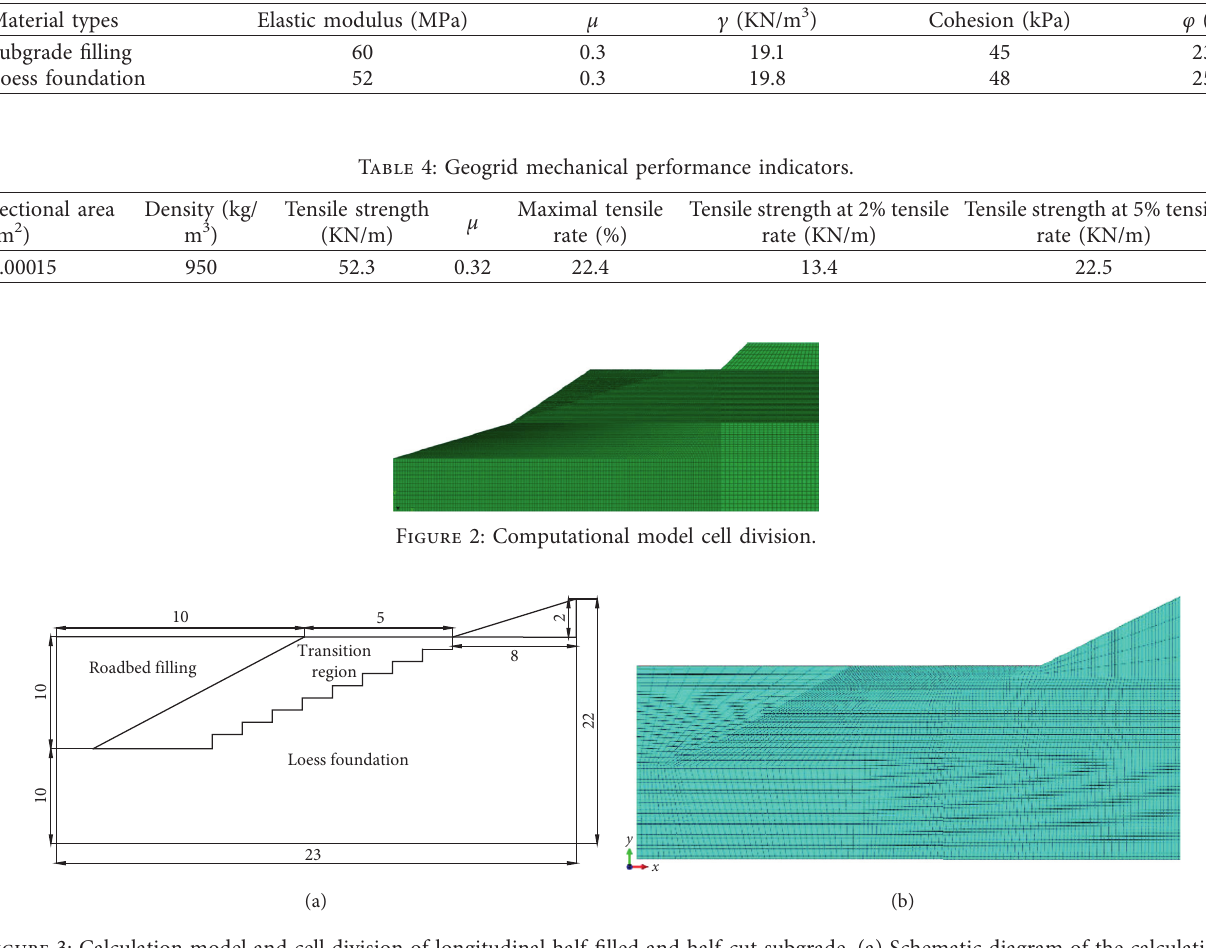
Table 3: Soil parameters.